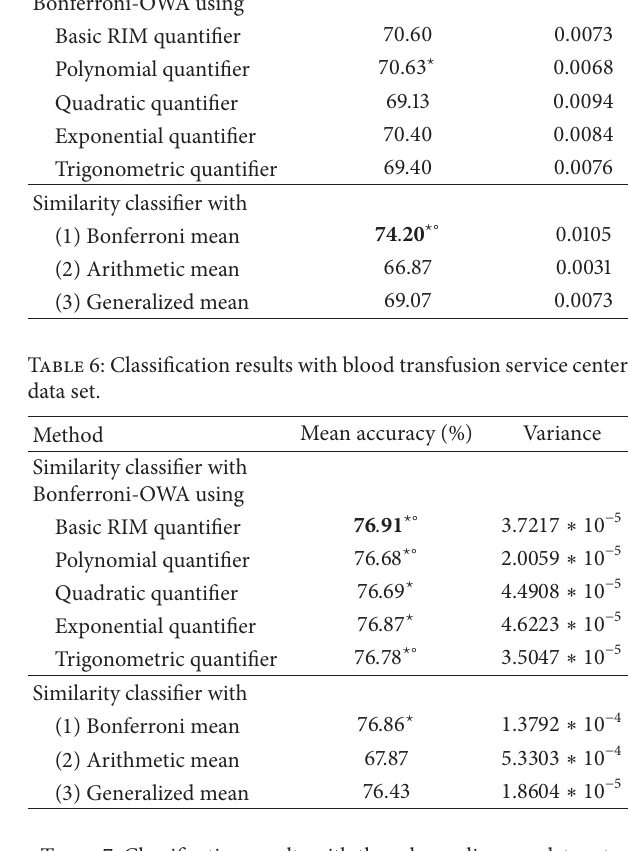
Table 7: Classification results with the echocardiogram data